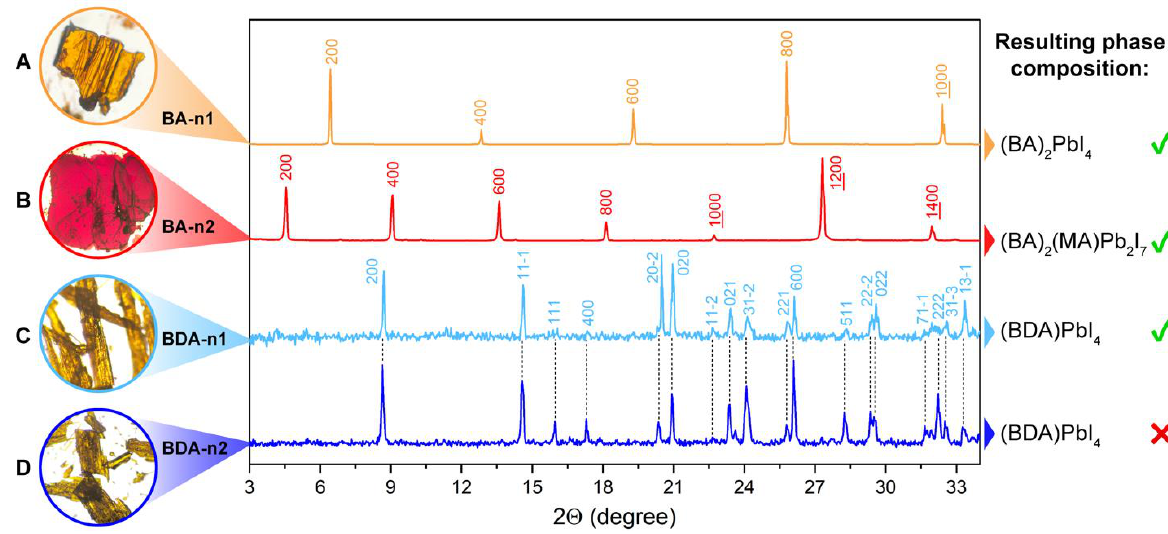
Figure 1. Optical photographs of single crystals, synthesized from solutions relevant to (BA) 2 PbI 4 ( A ), (BA) 2 (MA)Pb 2 I 7 ( B ), (BDA)PbI 4 ( C ), (BDA)(MA)Pb 2 I 7 ; ( D ) perovskite compositions and corre- sponding powder XRD patterns. On the right, the actual phase composition of each sample is given, indicating the failure to obtain the (BDA)(MA)Pb 2 I 7 compound.